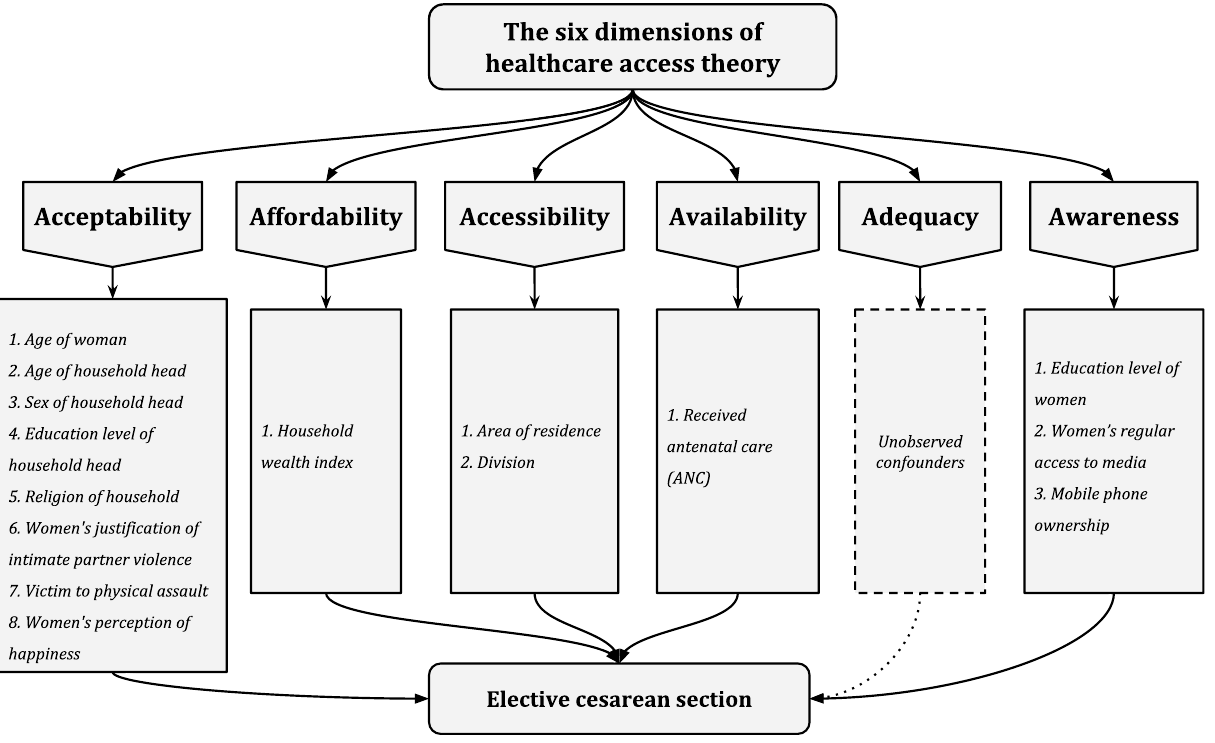
Figure 1. Theory of healthcare access in the context of women’s preference of exercising elective CS during